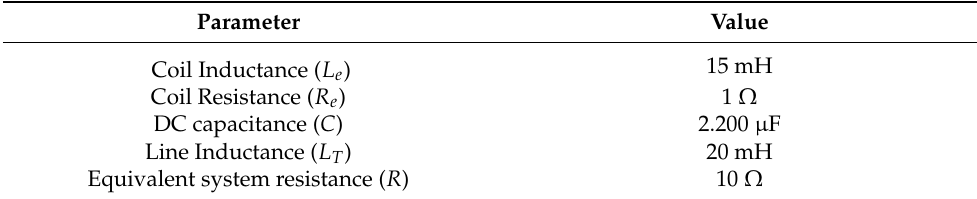
Table 1. Parameters of the WEC